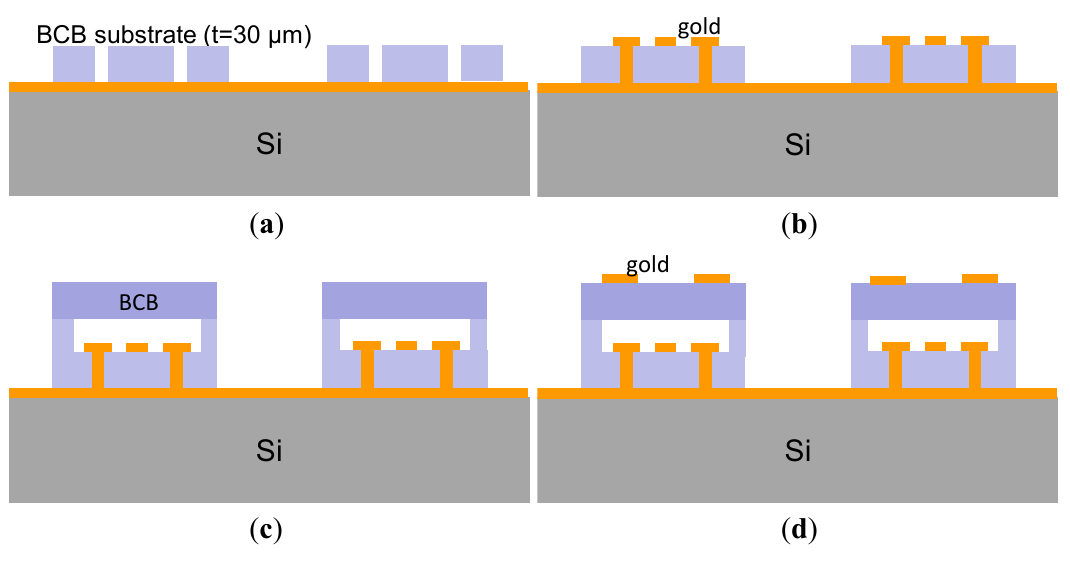
Figure 5. Fabrication process flow.